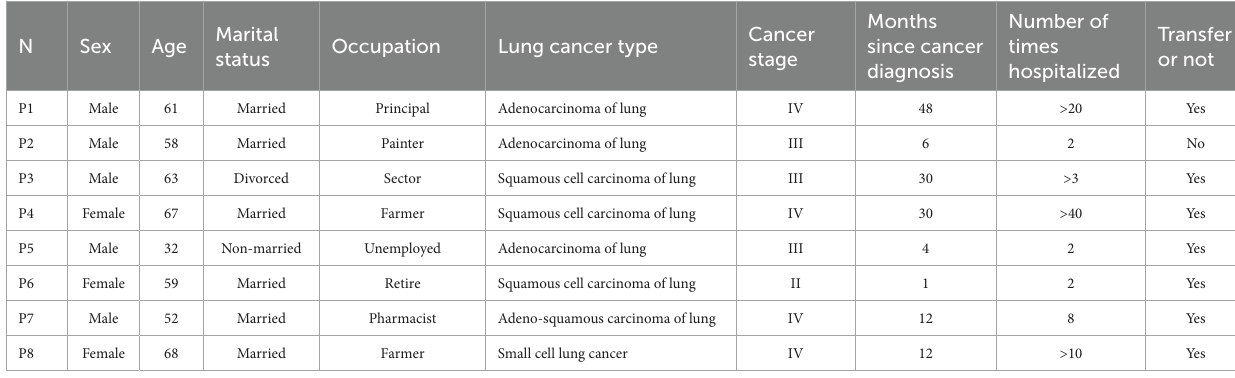
TABLE 4 Interviewees’ general information ( n = 8).